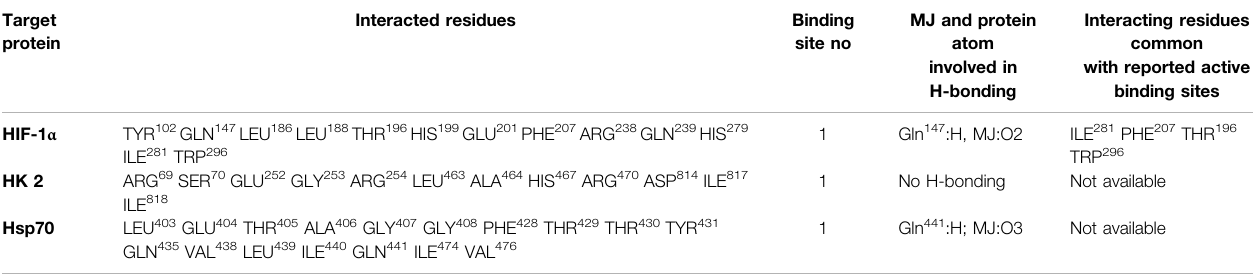
TABLE 1 | Characterization of the docking of MJ to indicated